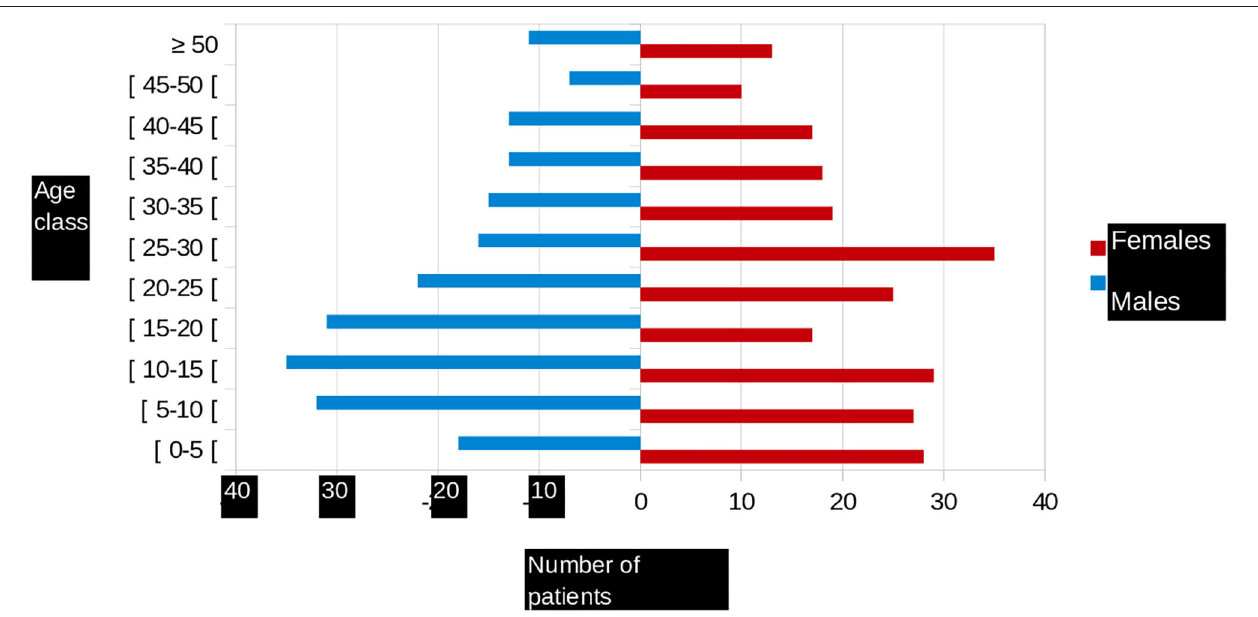
FIGURE 1 | Age pyramid of patients followed in French Guiana.